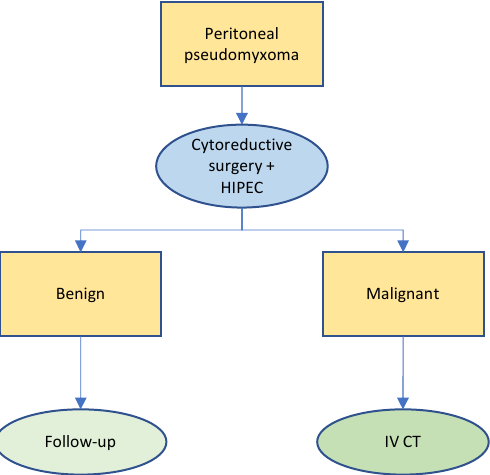
Figure 1. Treatment algorithm for pseudomyxoma